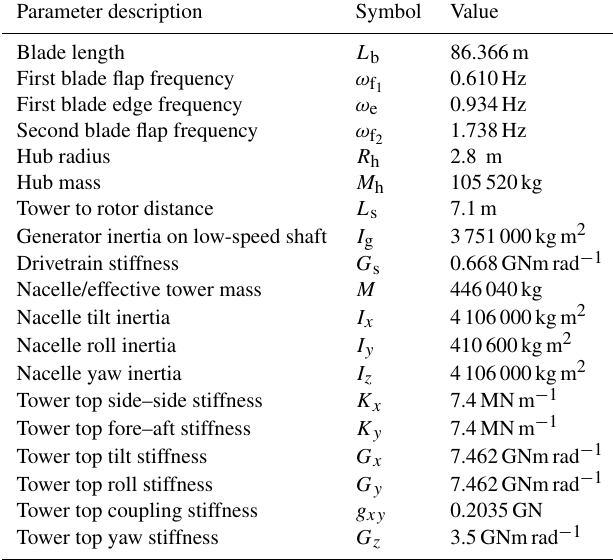
Table 1. Tuned parameters of simple model to fit the modal prop- erties of the DTU 10MW RWT up to its 11th mode.